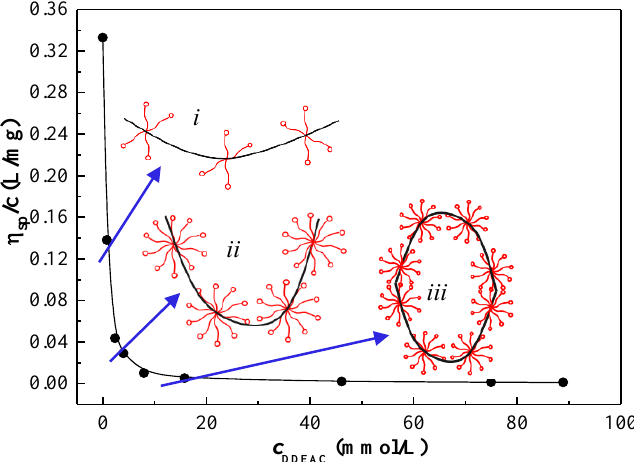
Figure 3. The relationship between reduced viscosity of GTA-m-CS/DDEAC and DDEAC concentration and schematic diagram of GTA-m-CS/DDEAC interaction (the insert). i — absorption of DDEAC molecules on GTA-m-CS molecule, ii — the formation of GTA-m-CS/DDEAC complexes, and iii-interaction between GTA-m-CS/DDEAC complexes.